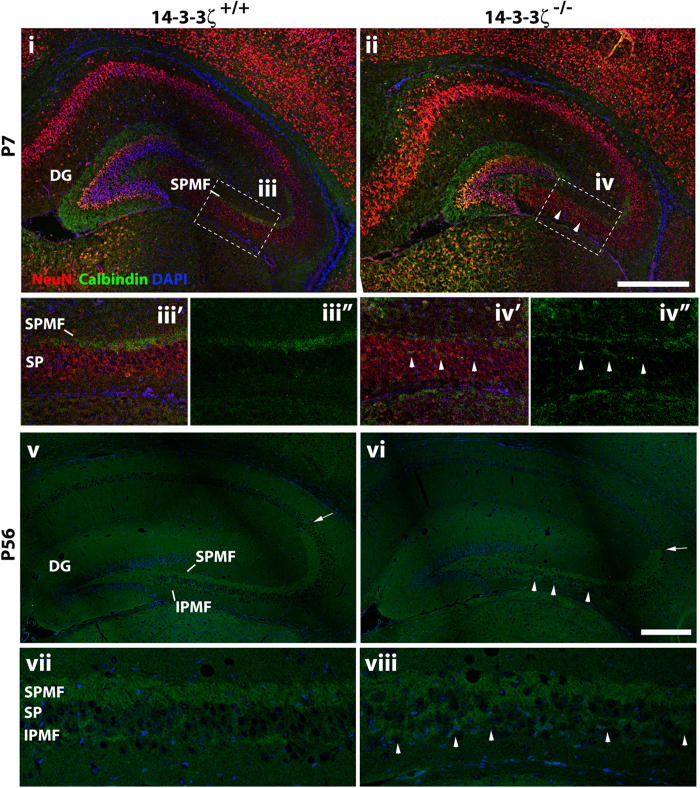
Abnormal connectivity of the hippocampus in 14-3-3ζ-deficient mice.Calbindin immunostaining of the infrapyramidal (IPMF) and the suprapyramidal (SPMF) mossy fibre trajectories. At P7 (i–iv) the calbindin mossy fibres are seen along the SPMF branch navigating away from the dentate gyrus (DG) in both 14-3-3ζ+/+ and 14-3-3ζ−/− mice. In 14-3-3ζ−/− mice the SPMF (green) branch aberrantly navigates among the NeuN positive (red) pyramidal cell somata (sp, arrowheads) in CA3. (iii’) higher magnification of boxed area in (i) and (iii”) higher magnification of calbindin staining from boxed area in (i). (iv’) Higher magnification of boxed area in (ii) and (iv”) higher magnification of calbindin staining from boxed area in (ii). At P56 (v-viii) the SPMF and IPMF branches of 14-3-3ζ−/− mice navigate aberrantly among the pyramidal cell somata (arrowheads) in CA3 and, the SPMF is shorter than in 14-3-3ζ+/+ mice (arrow). (vii and viii) higher magnification of the boxed regions in (v) and (vi), respectively. Scale bars = 100 μm.